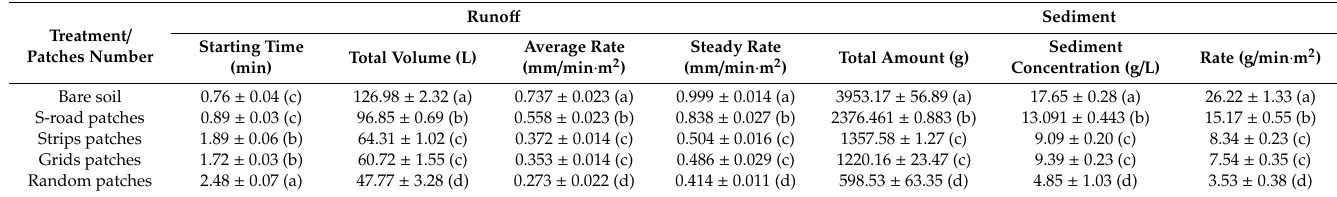
Table 3. Run-o ff and sediment yields for di ff erent types of vegetation patches under simulated rainfall.